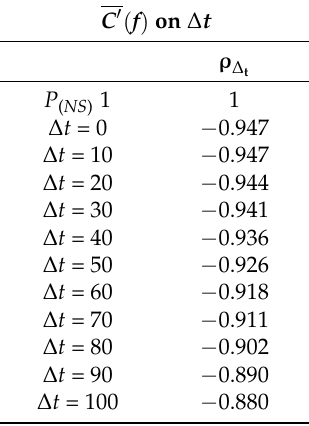
Table 3. Correlation % between C (cid:48) ( f ) for given ∆ t levels and P ( NS ) , which indicates the dependence of travel delay on the uncertainty in travel information.